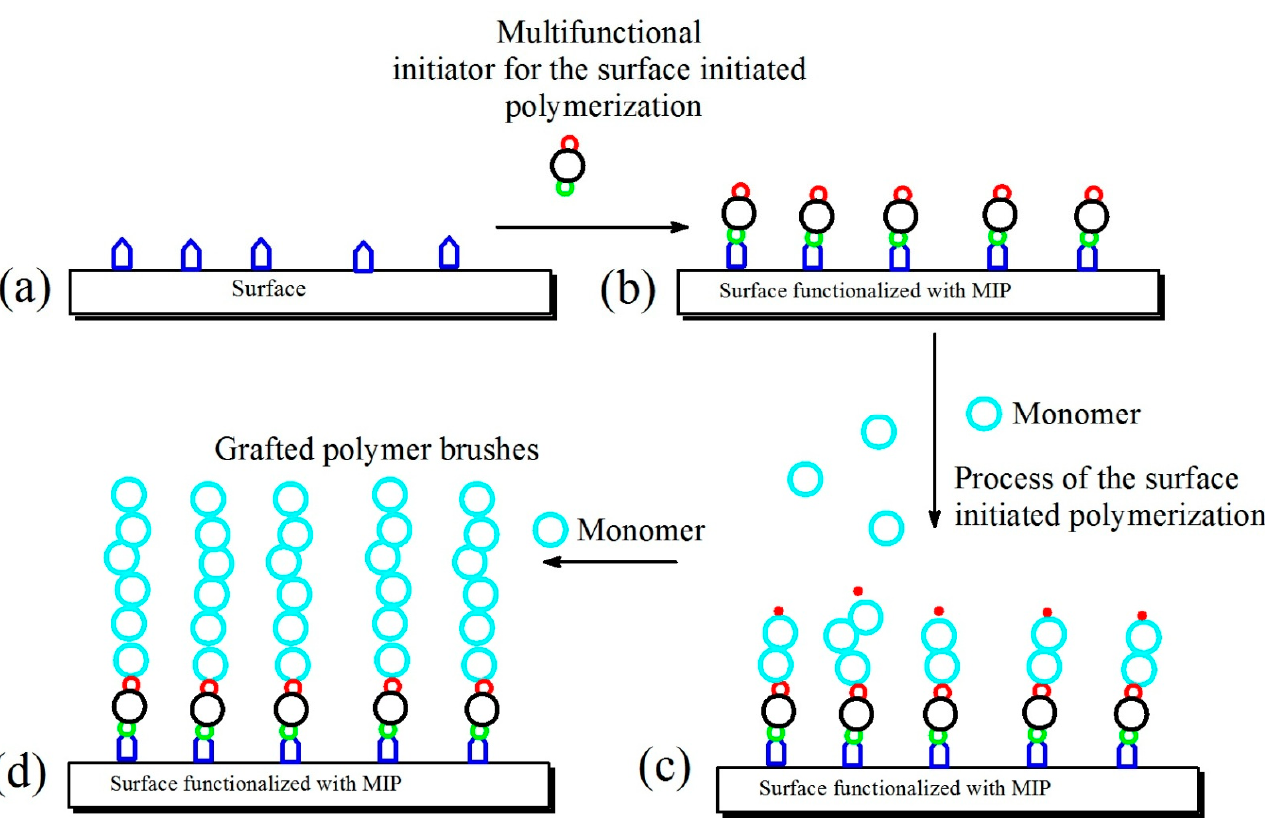
Figure 4. Functionalization of surfaces ( a ), subsequent grafting of a multifunctional initiator for a controlled living surface-initiated polymerization ( b ) , polymerization of a reactive monomer, initi- ated by reactive groups of the multifunctional initiator ( c ) , and the resulting grafted polymer brushes ( d